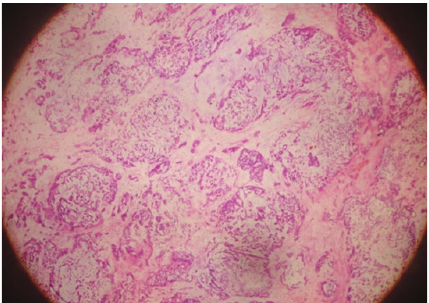
Figure 3: The histological features of the pleomorphic adenoma (40